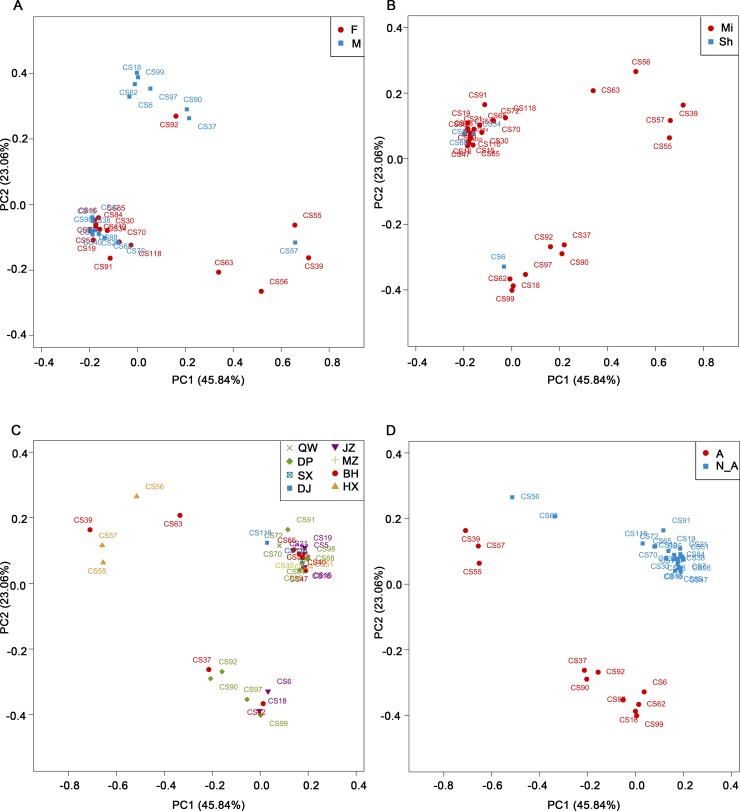
Diversities in the spleen microbiota of 35 mice and shrews.Principal coordinate analysis (PCoA) plots of the spleen microbiota based on the Bray-Curtis metrics considering animal genders, types, geographic sites or infection with Anaplasma. (A), male versus female groups. (B), mouse versus shrew groups. (C), different geographic site groups. (D), Anaplasma-positive versus Anaplasma-negative groups. F: female; M: male. Mi: mice; Sh: shrews. A: Anaplasma-positive; N_A: Anaplasma-negative.